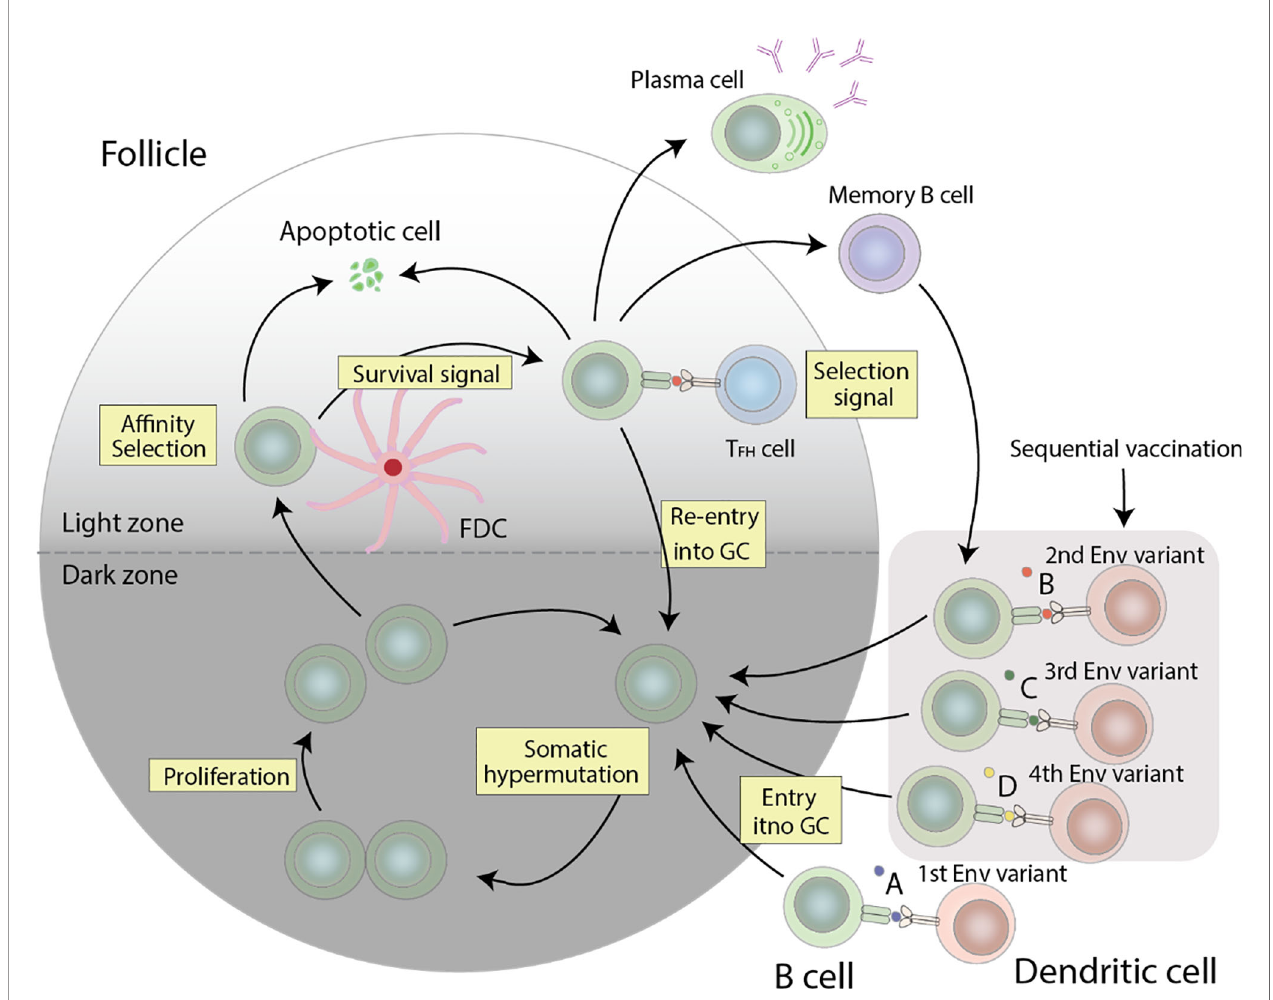
FIGURE 2 | Germinal center reactions that can lead to the production of anti-HIV-1 bNAbs. HIV-1 speci fi c B cells undergo proliferation and somatic hypermutation of the BCR in the dark zone, followed by af fi nity selection in the light zone. The resulting cells compete for the limited Tfh cell help, and cells with a high af fi nity BCR get more help than those with a low af fi nity BCR, which consequently undergo apoptosis. The surviving cells can either differentiate into plasma cells, re-enter the GC for additional rounds of somatic hypermutation and proliferation, or differentiate into memory cells. Re-entry of these memory cells with stimulation from other Env variants will allow for further af fi nity maturation. The combination of these events forms a cycle needed to generate anti-HIV-1